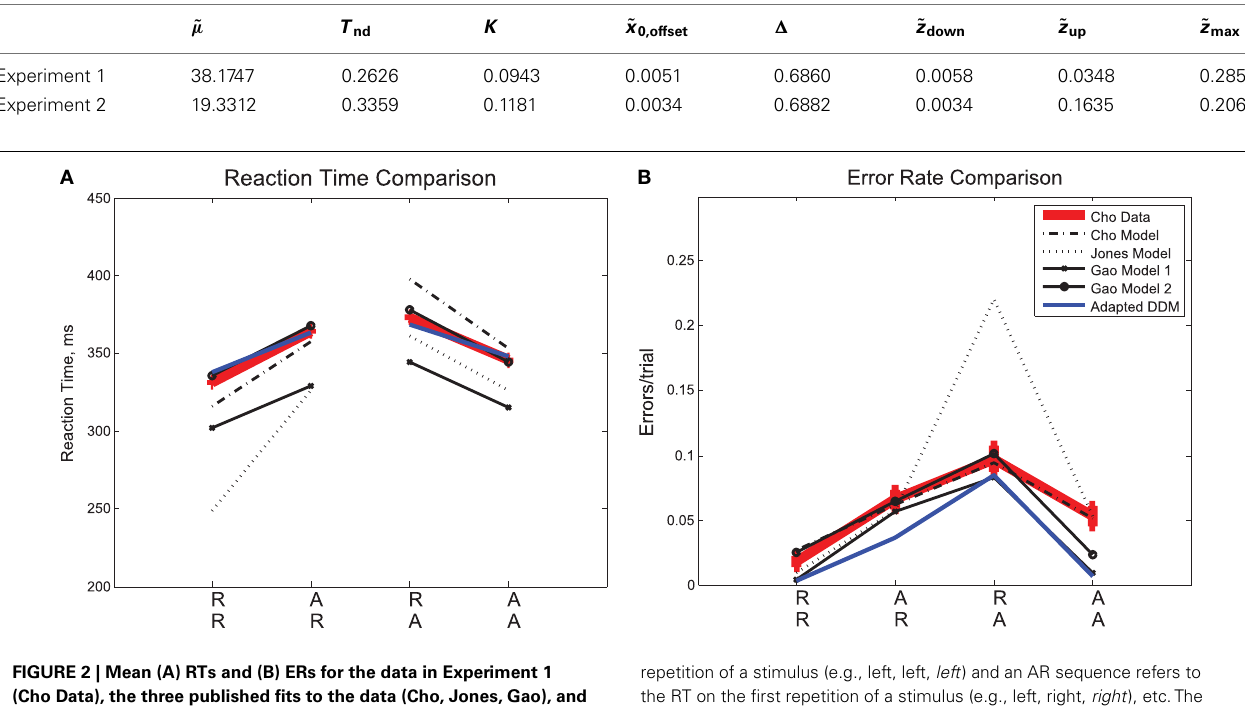
Table 1 | DDM parameterization.